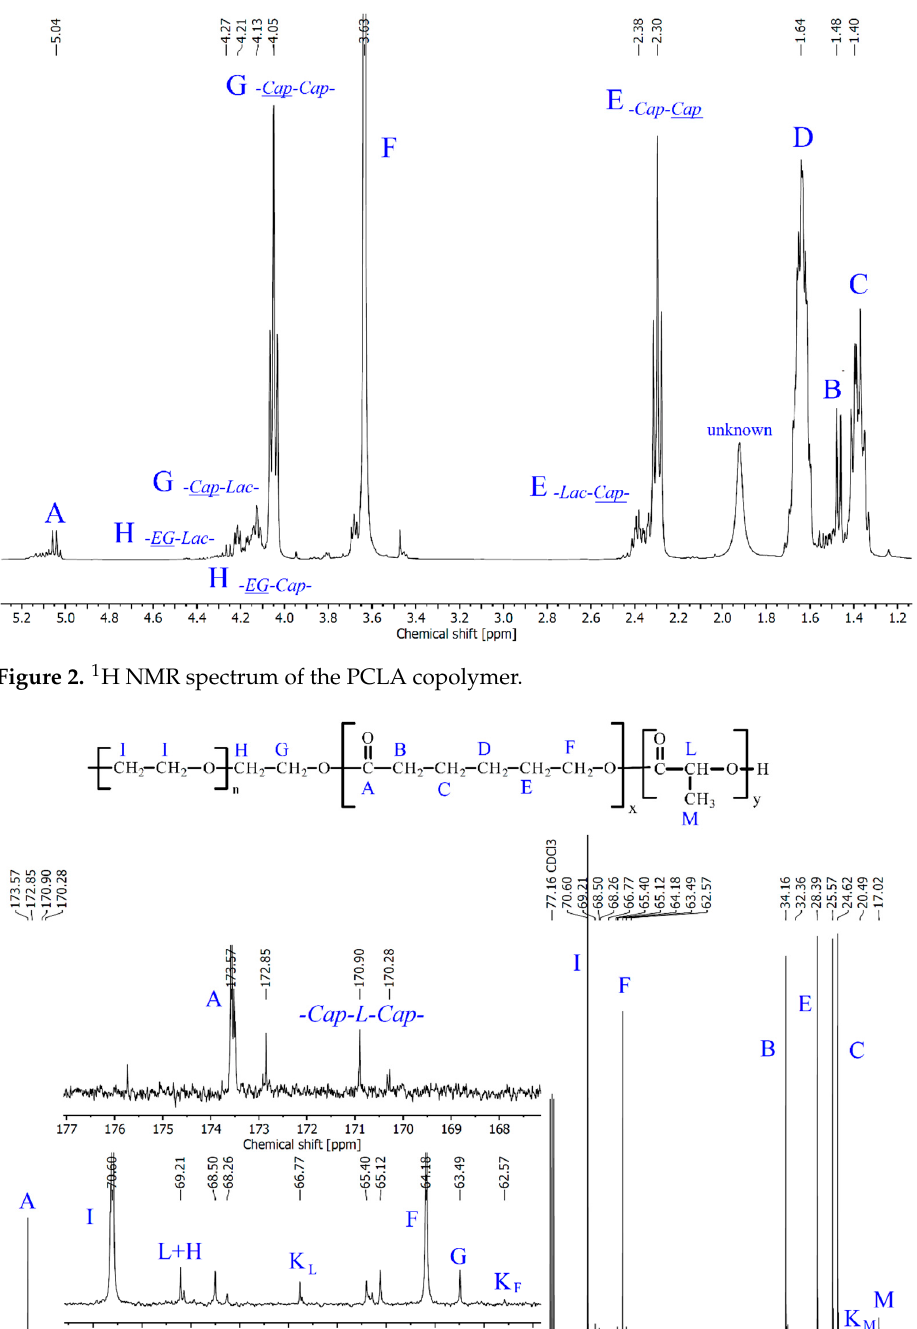
Figure 3. 13 C NMR spectrum of the PCLA copolymer. K M , K F and K L refer to the M, F and L atoms in the copolymer chain end groups, respectively.